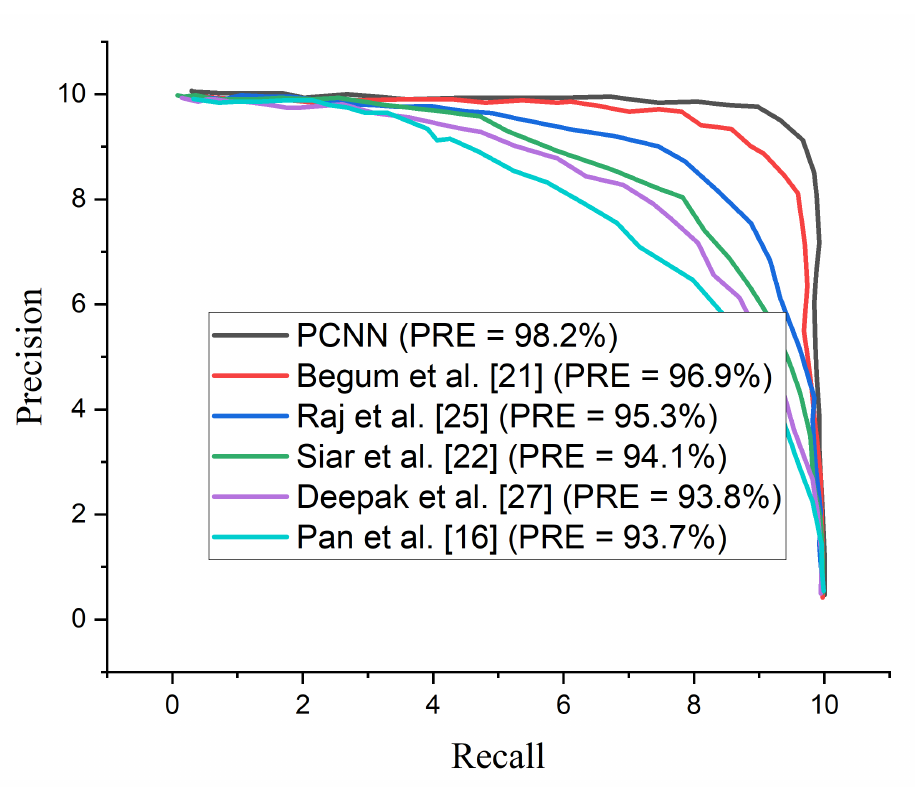
Figure 11. Precision–Recall curves for the proposed PCNN in comparison with some selected state of the art models using the same